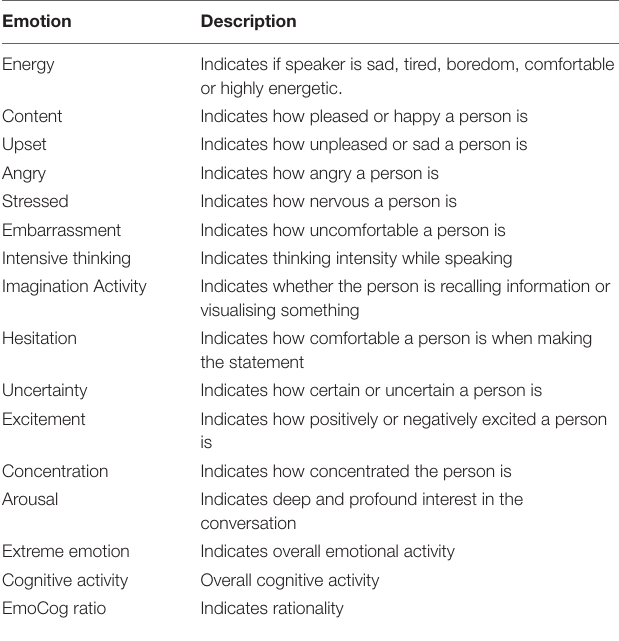
TABLE 1 | Definitions of emotion labels produced by Nemesysco/Layered voice analysis. Emotion